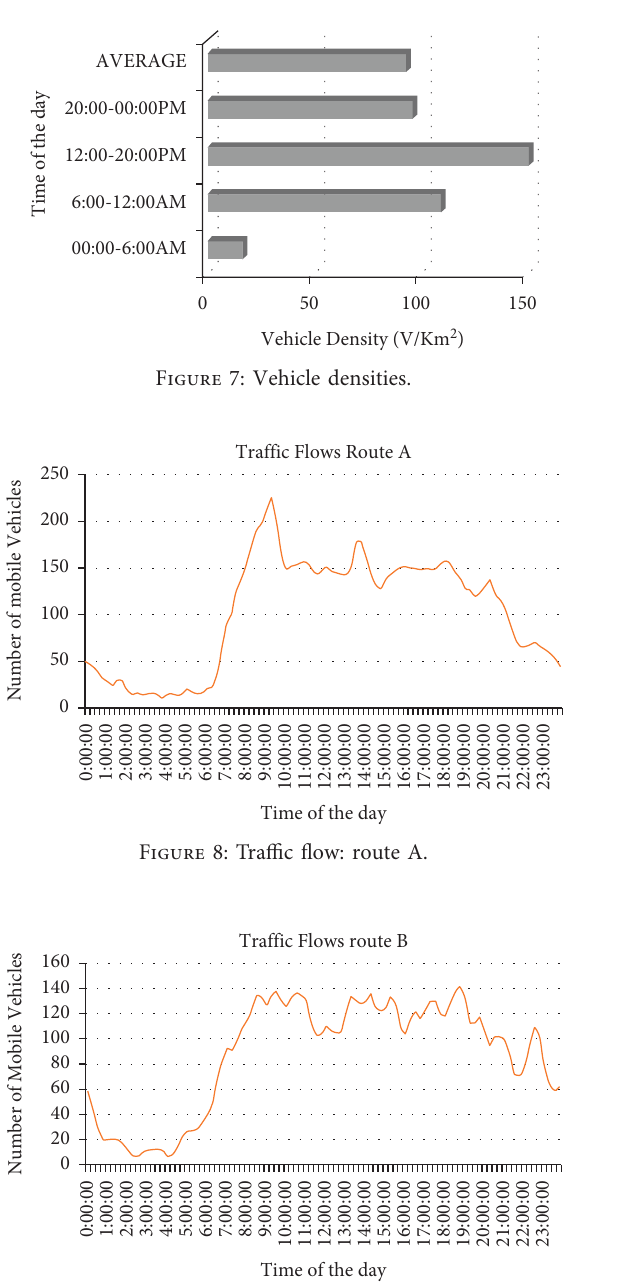
Figure 12: Traffic flow: route E.